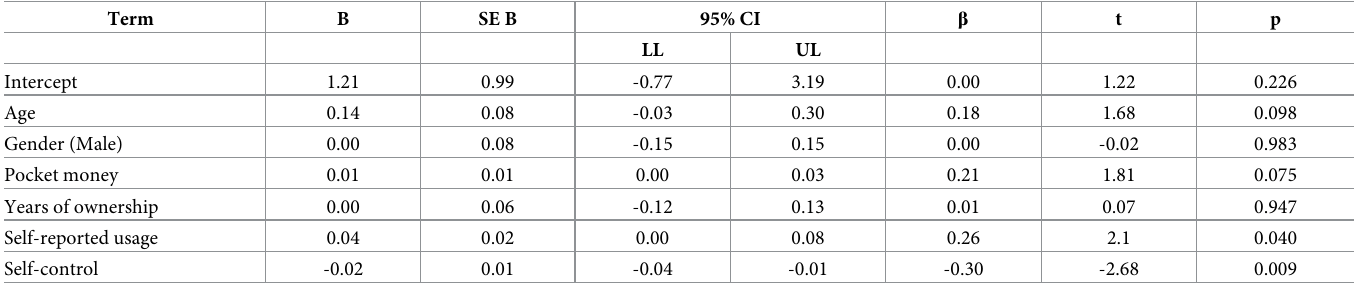
Table 4. Multiple regression analysis of predictors of grade